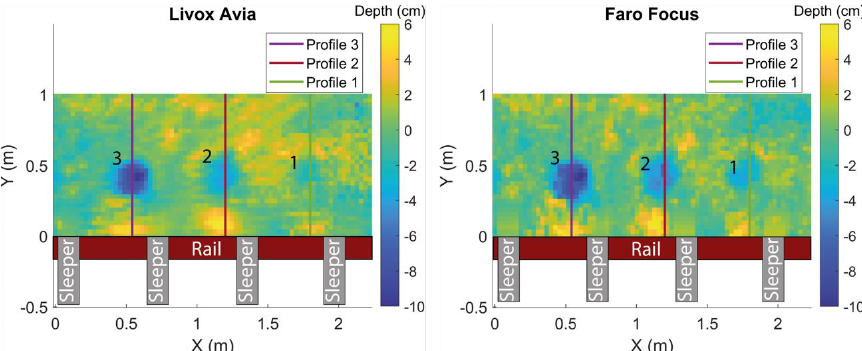
Figure 7. Digital elevation models of the ballast and locations of the profiles of the LiVOX Avia (left) and Faro Focus 3D (right) under study.